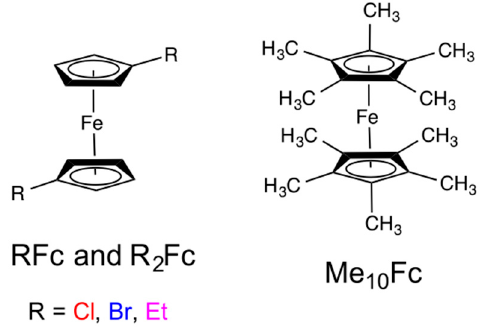
Figure 9. Structure of ferrocene derivatives.